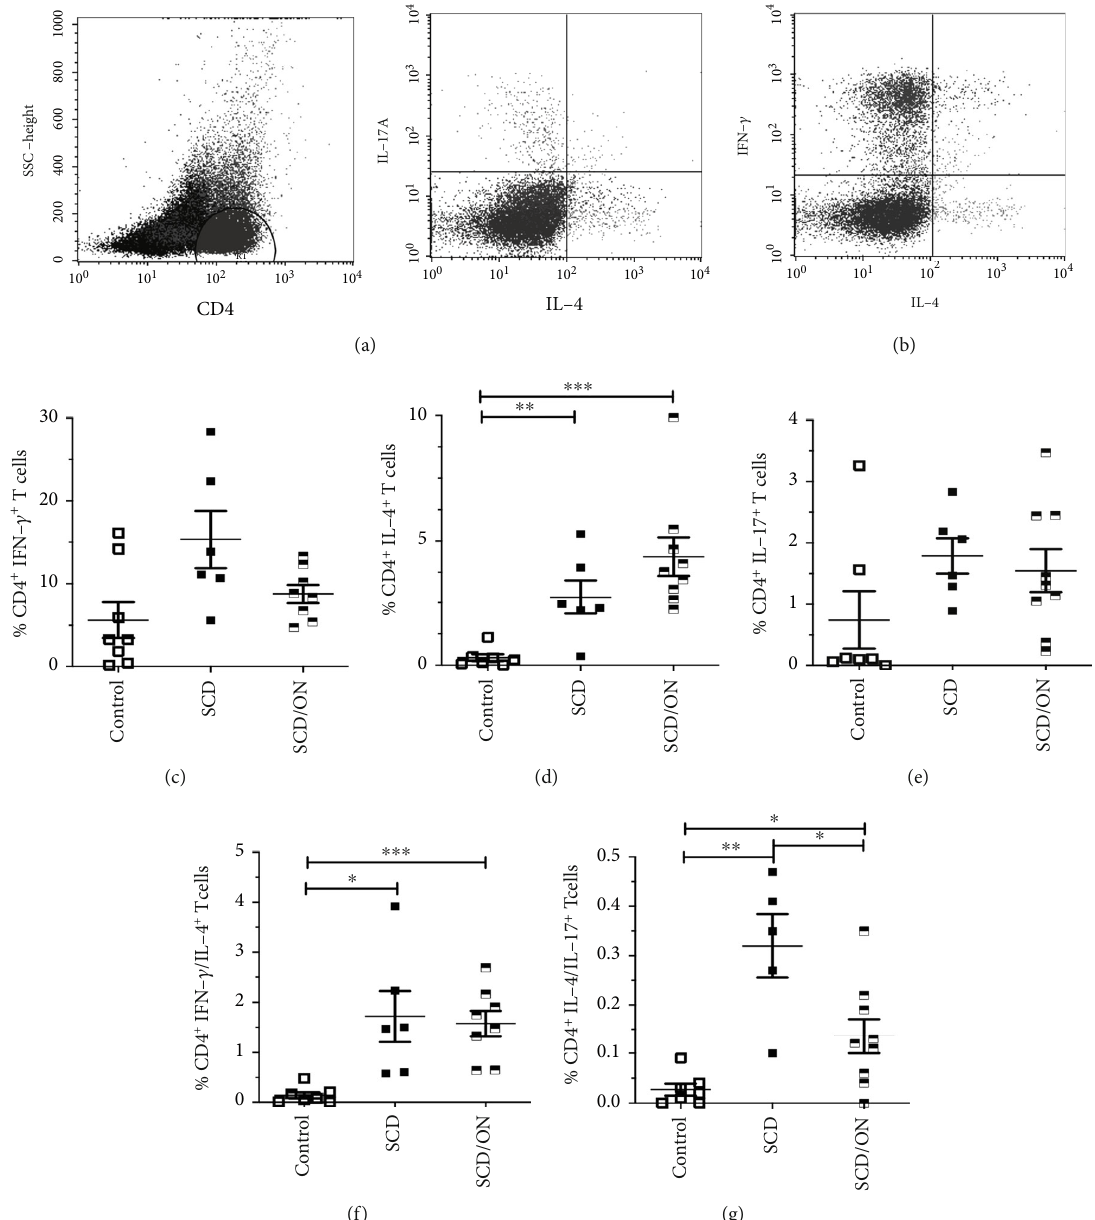
Figure 3: Increased frequency of IL4 + CD4 + T cells and bifunctional IFN- γ + / IL4 + and IL-17 + / IL4 + CD4 + T cells in SCD and SCD/ON compared to healthy controls. Peripheral blood mononuclear cells from healthy donors (control), steady-state SCD, and SCD with osteonecrosis (SCD/ON) patients were culture stimulated with PMA/Io and stained for intracellular cytokine production. Representative dot plots illustrate intracellular staining for IFN- γ + /IL-4 + (a) and IL-4 + /IL-17 + (b) in TCD4 + cells after stimulation. Relative frequency of IFN- γ + (c), IL-4 + (d), IL-17 + (e), bifunctional IFN- γ + /IL-4 + (f), and IL-4 + /IL-17 + TCD4 + (g) cells producing cytokines in relation to total TCD4 + cells in culture. Each symbol represents an individual subject. Horizontal lines represent mean and standard error. ∗ p < 0 : 05 , ∗∗ p < 0 : 005 , and ∗∗∗ p < 0 : 0005